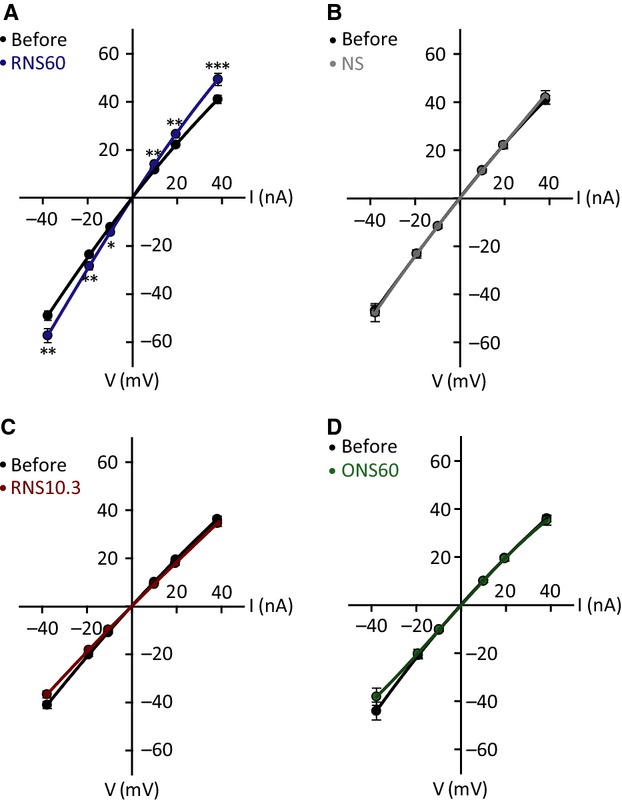
Membrane potential changes as a function of current injection (I–V curve) in the presence of RNS60 (A, average of 16 experiments), NS (B, average of 13 experiments), RNS10.3 (C, 14 experiments) and ONS60 (D, 10 experiments). *P < 0.05, **P < 0.01 and ***P < 0.001 two-way ANOVA/Tukey's post-hoc test.